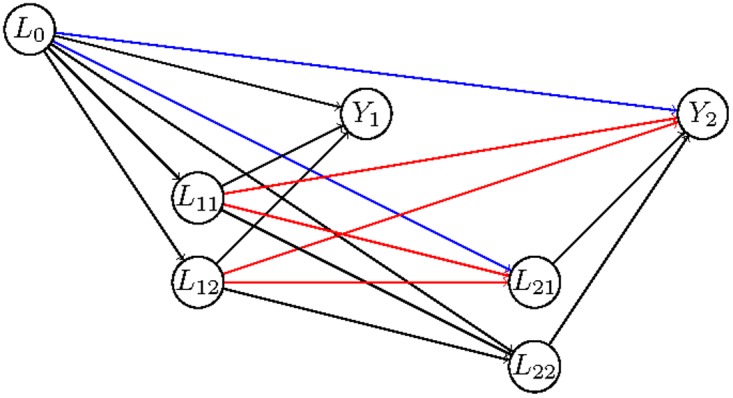
Directed acyclic graph, the arrows in blue and red denote the relations that confound the causal effect of L
21 on Y
2.